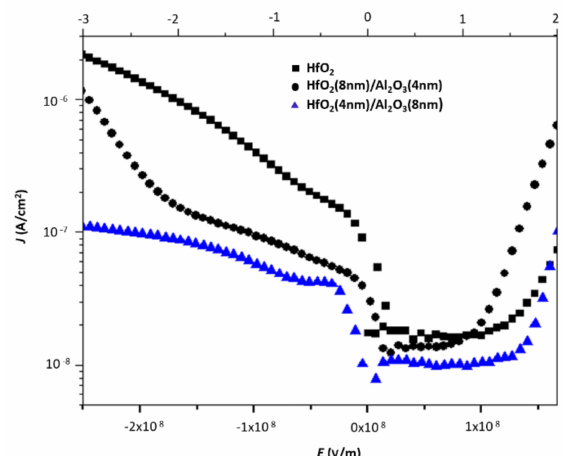
Figure 5. Leakage current density J leakage measurements under bias voltage from − 3 to 2 V for the three MOS